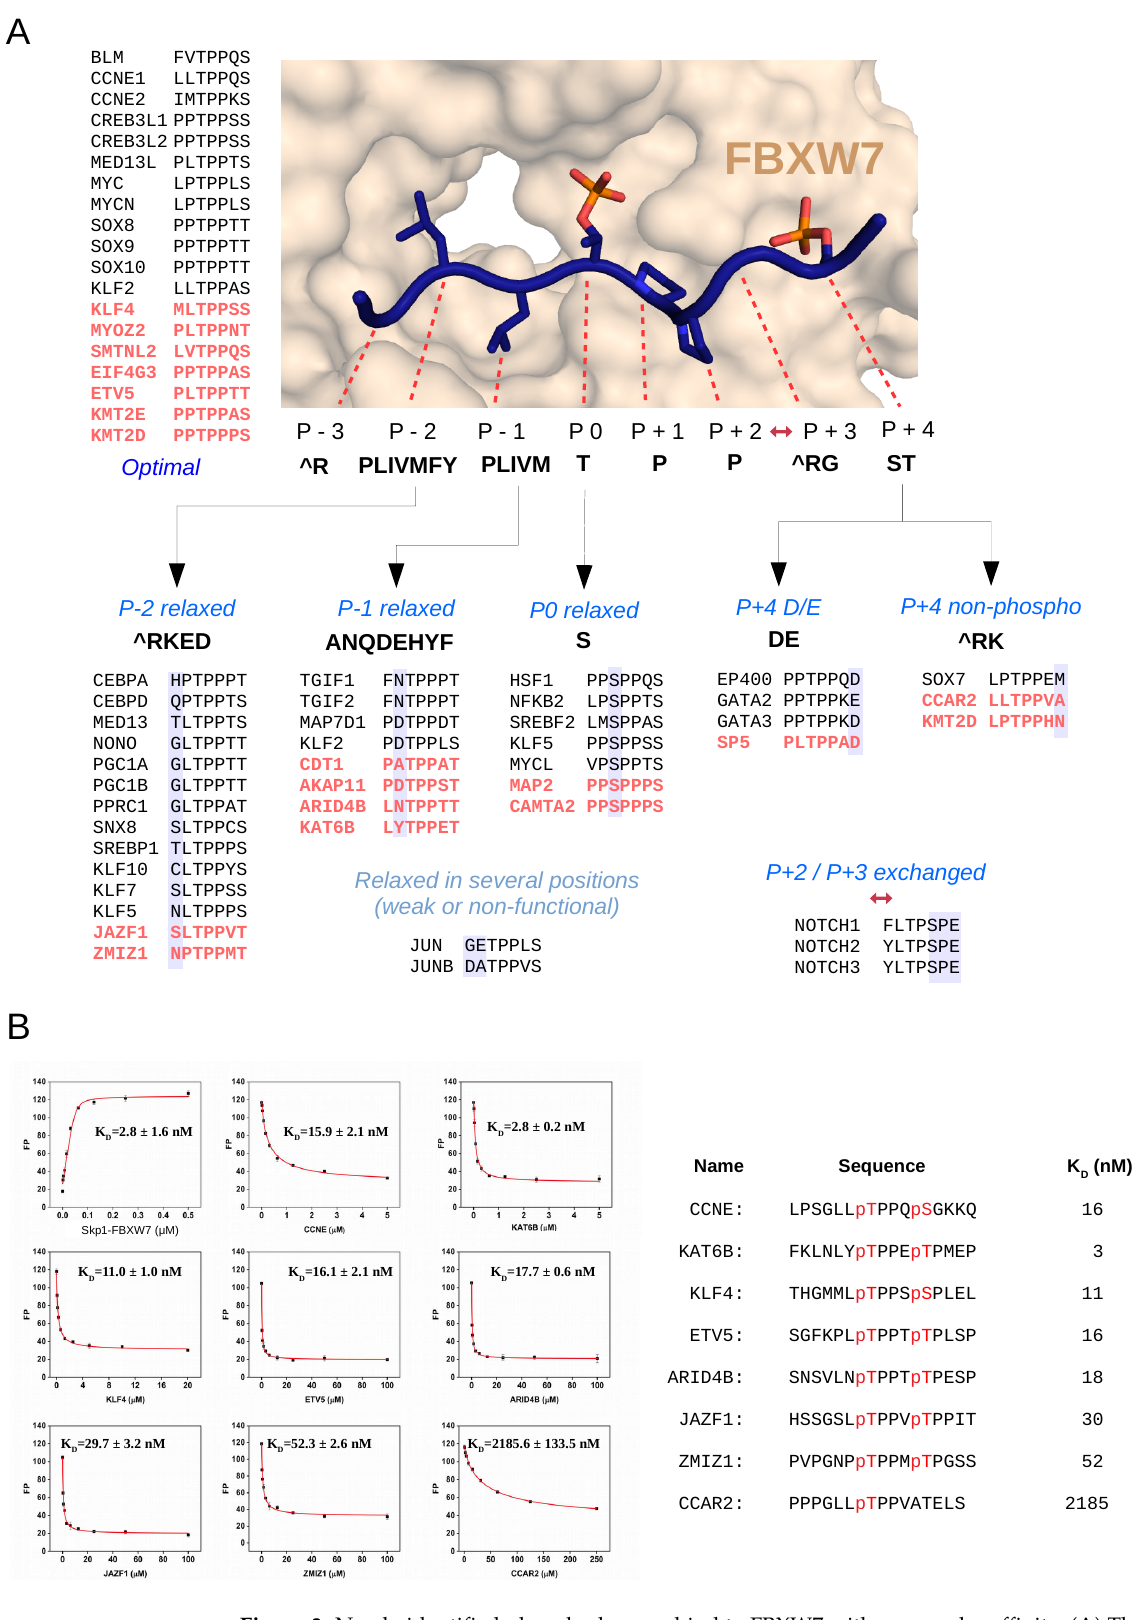
Figure 3. Newly identified phosphodegrons bind to FBXW7 with nanomolar affinity. ( A ) The scheme of the position–relaxation model describing FBXW7 binding phosphodegron motifs. The structural panel shows the crystal structure of the FBXW7(WD40)-CCNE peptide complex (PDB ID: 2OVQ)